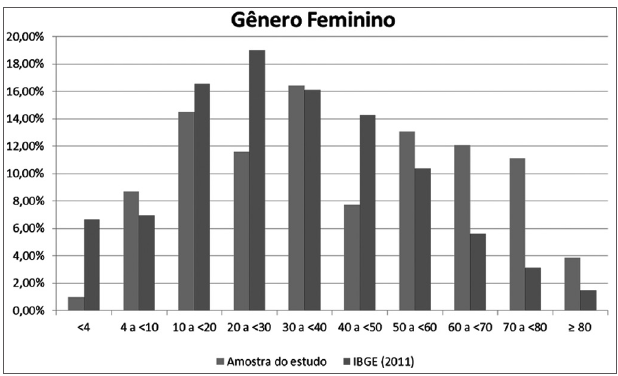
Figura 2. Comparativo da distribuição da amostra do sexo feminino, por faixa etária, com os dados populacionais (IBGE, 2011).